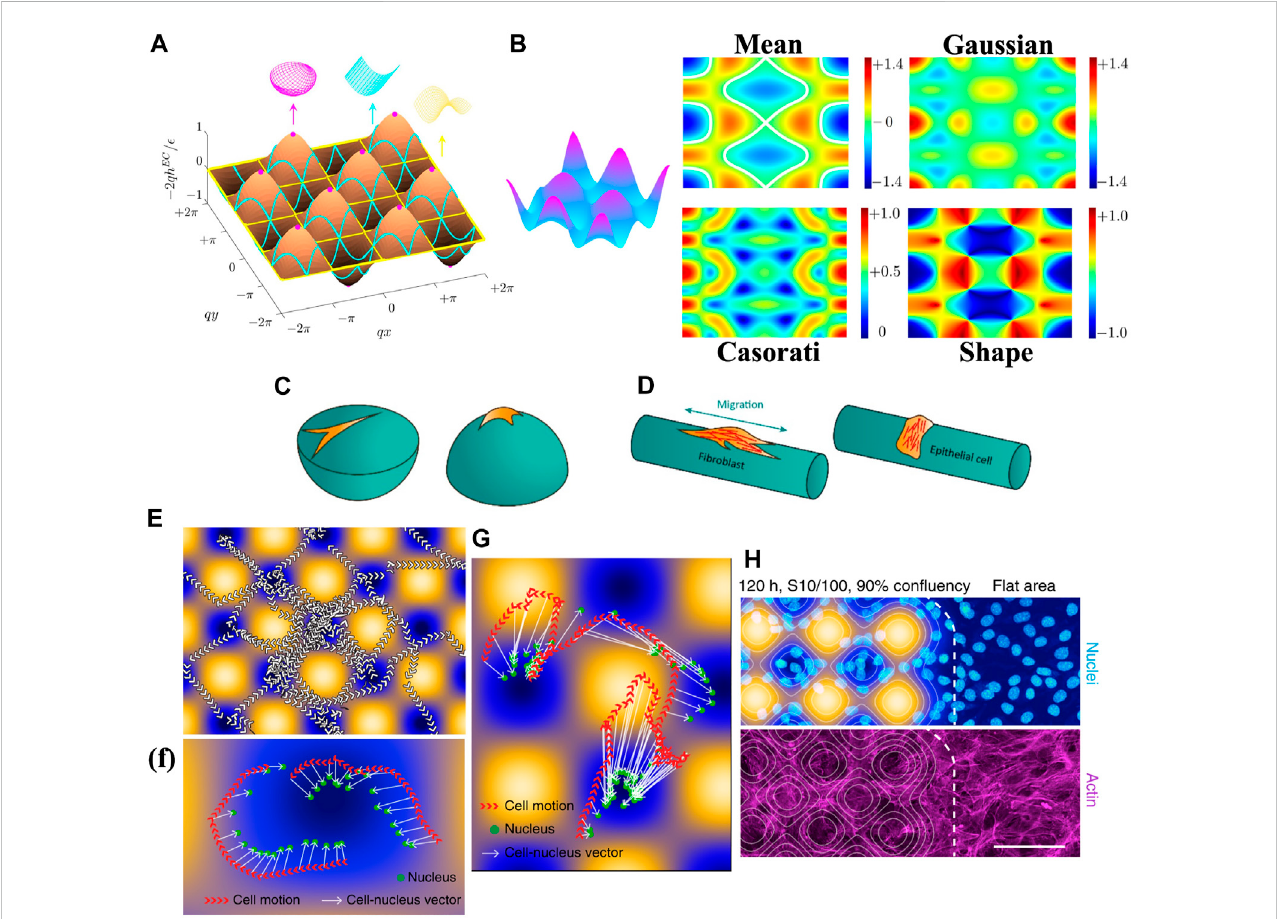
FIGURE 9 (A – D) present curvature-induced cell alignment. (A) The curvature lines on an egg carton surface. Megenta points represent local spheres. Cyan and purples curves represent the local cylinders and local saddles, respectively. (B) A surface with 5/31 egg carton wrinkling, 10/31 cylindrical wrinkling, and 16/31 asymmetric biaxial wrinkling pattern. The dimensionless mean, Gaussian, Casorati curvatures and shape parameter distribution on the surface. (C) Concave and convex spheres do not support the cells in the same way. (D) Fibroblastic-like cells tend to align along the long axis of cylinder, while epithelial cells prefer to wrap the cylinder. (E – H) present curvature-induced cell migration. (E) Tracking of nuclei. Arrows represent moving direction. Arrowheads indicate movementdirection. (F) and (G) Trackingofcellsandnucleibarycentersofcellsoneggcartonsurface. (H) CellsstainedforDNAandactin.Scalebars:100 µm. (A) Is reprinted from (Wang Z. et al., 2021), Copyright (2021), with permission from Elsevier. (B) Is reprinted from (Wang et al., 2022). Copyright (2020) by the AmericanPhysical Society. (C) and (D) arereproducedunderCC-BY-4.0 (Callensetal.,2020). (E – H) arereproduced